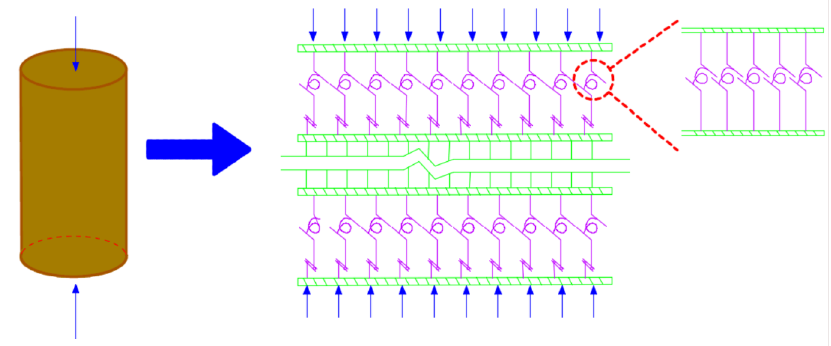
Figure 3. Schematic diagram of the UCS test micro spring